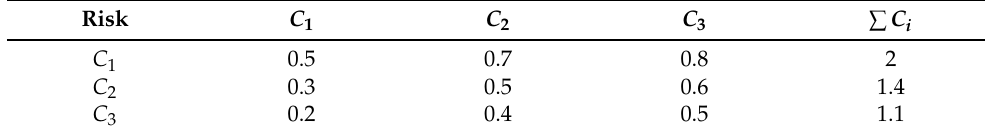
Table 4. Attribute pairwise comparison result.